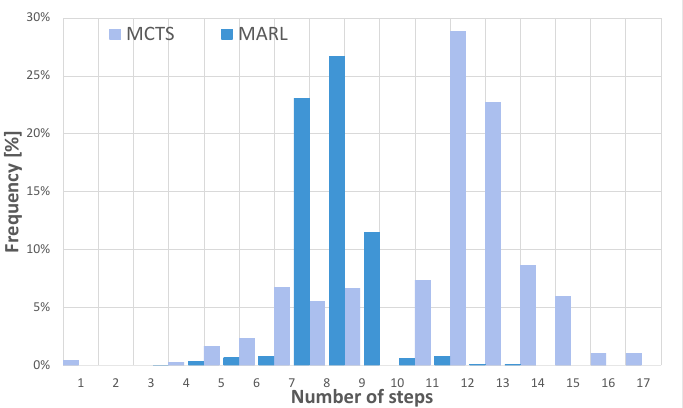
Figure 7. Comparison of the vector-based MADRL and MCTS